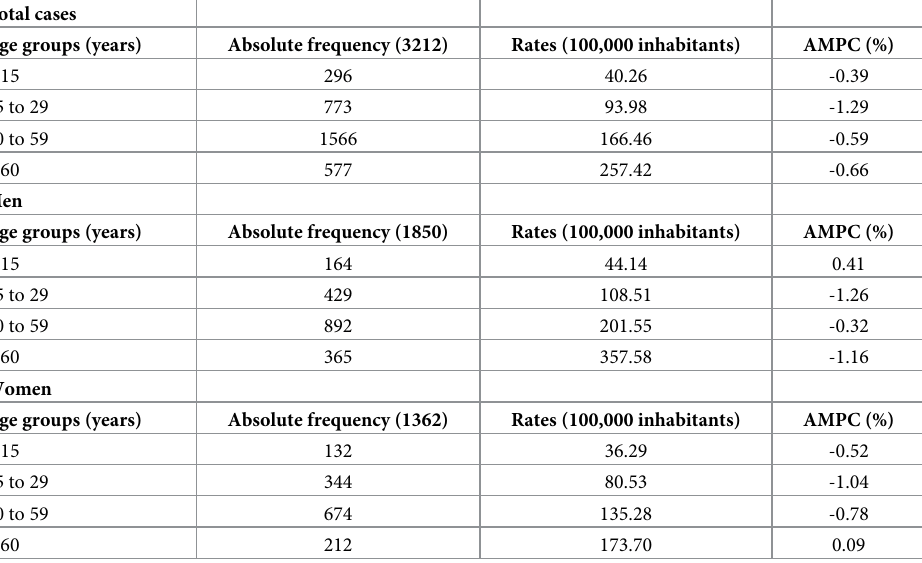
Table 1. Profile of leprosy cases according to sex, age group, and average percentage of rates, Imperatriz, MA, Brazil